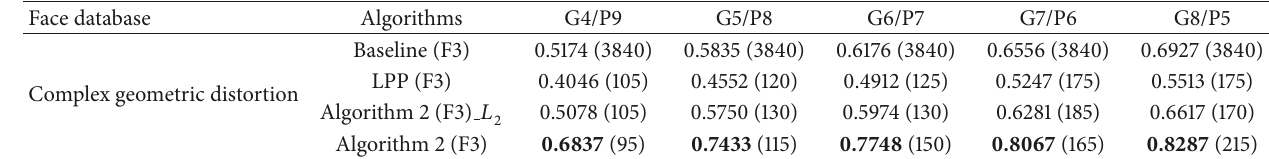
Table 13: The recognition rates on complex geometric distortion AR face database over “F3” features; recognition rates (dimensionality). Face database